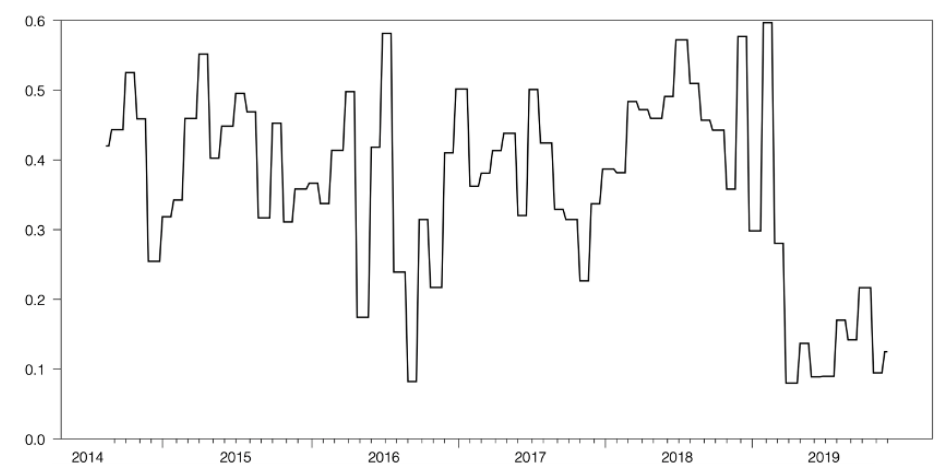
Figure 1. Proportion of Total Canadian Canola Exports that are Imported by China.